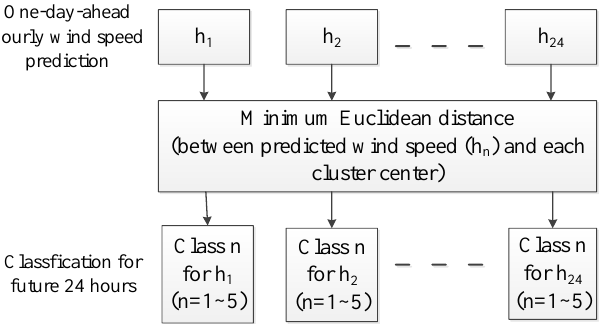
Figure 7. Schematic diagram of class selection for future prediction points.